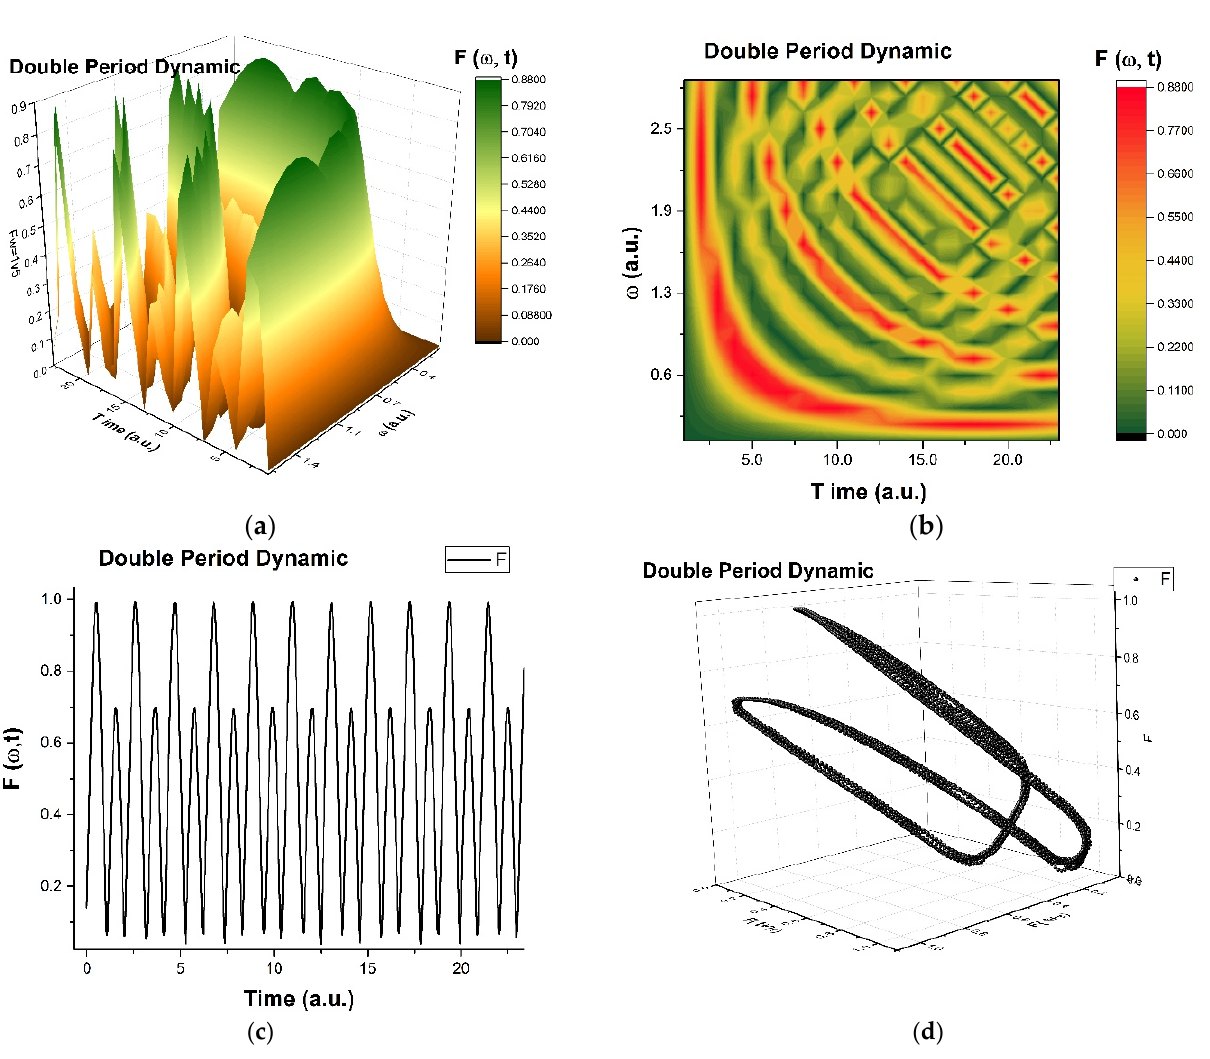
Figure 9. ( a – d ): The ”double period dynamic modes” in mastication of the structural units of dental composite materials dynamics are presented: ( a )—3D diagram, ( b )—contour diagram, ( c )—time series and ( d )—reconstituted attractor for scale resolutions given by Ω max .